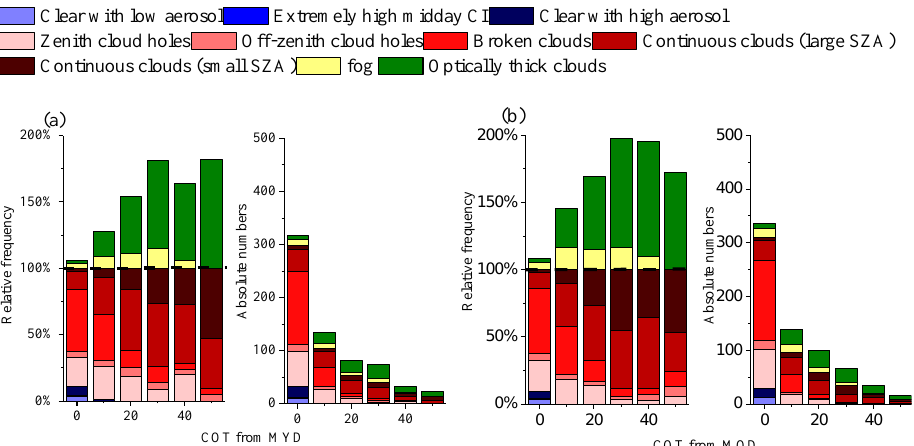
Figure 17. Results of the cloud classification scheme as a function of the cloud optical thickness (COT) from MODIS on Aqua (MYD) (a) and on Terra (MOD) (b) , both for measurements with geometrical CF>80% only. The left parts of the figures present the relative frequencies of the different sky conditions (see the caption of Fig. 10). The right parts of the figures present the absolute numbers of the sky